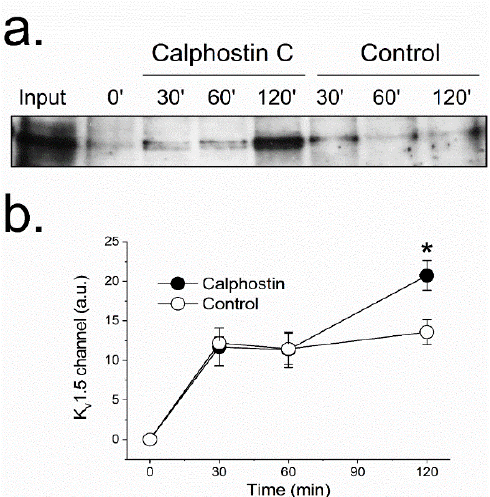
Figure 3. PKC inhibition modifies the K V 1.5 recycling. Recycling was analyzed with a biotinylation test (see Materials and Methods). Western blot of internalized channels (biotinylated) at different times (30, 60 and 120 min) under control and after PKC inhibition with calphostin C ( a ). Densitometric analysis of all the experiments performed ( b ). Each value represents the mean ± SEM of three experiments. * p < 0.05.